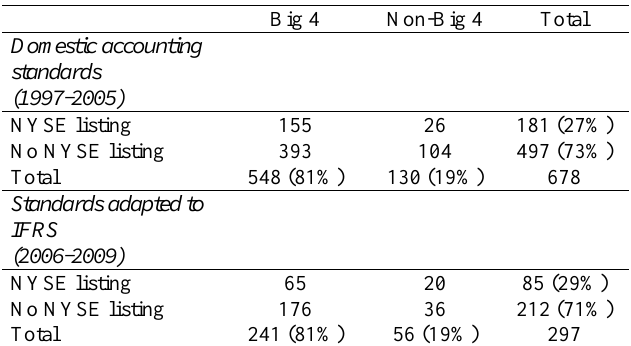
Table 2: Number of observations by accounting standards, auditor and